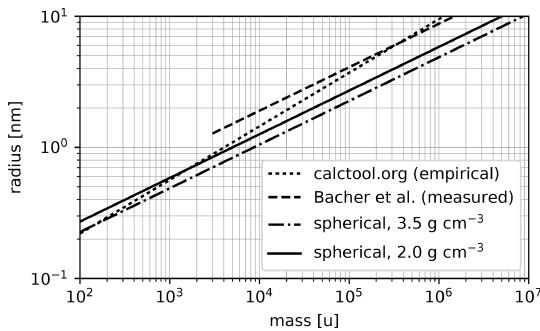
Figure 1. Comparison of different relationships between molecule mass and size with data from Bacher et al. (2001) and Shipway and Shipway